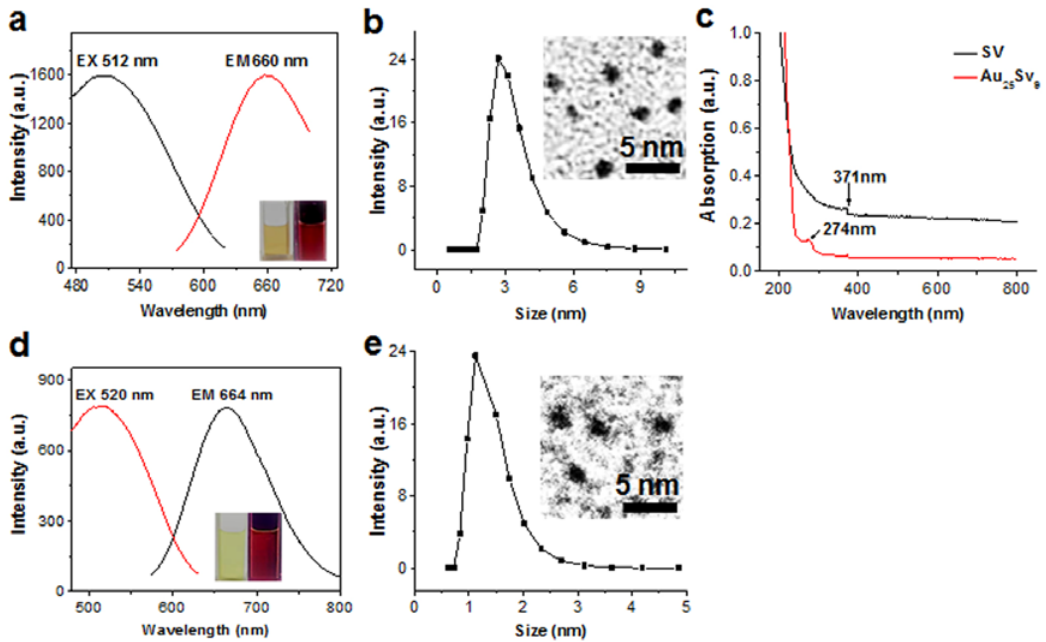
Figure 1. Characterization of the as-synthesized gold clusters. ( a ) The fluorescence excitation (512 nm) and emission spectra (660 nm) of Au 25 Sv 9 . Inset: digital images of the Au 25 Sv 9 under sunlight (left) and ultraviolet light (right). ( b ) Size distribution of Au 25 Sv 9 measured by dynamic light scattering (DLS). Inset shows a representative transmission electron microscopy (TEM) image of Au 25 Sv 9 , scale bar 5 nm. ( c ) UV-Vis (Ultraviolet-visible absorption spectra) analysis of the Sv peptide and Au 25 Sv 9 clusters. ( d ) The fluorescence excitation (520 nm) and emission spectra (664 nm) of Au 25 SG 27 . Inset: digital images of the Au 25 SG 27 under sunlight (left) and ultraviolet light (right). ( e ) Size distribution of Au 25 SG 27 measured by DLS. Inset shows a representative TEM image of Au 29 SG 27 , scale bar 5 nm.